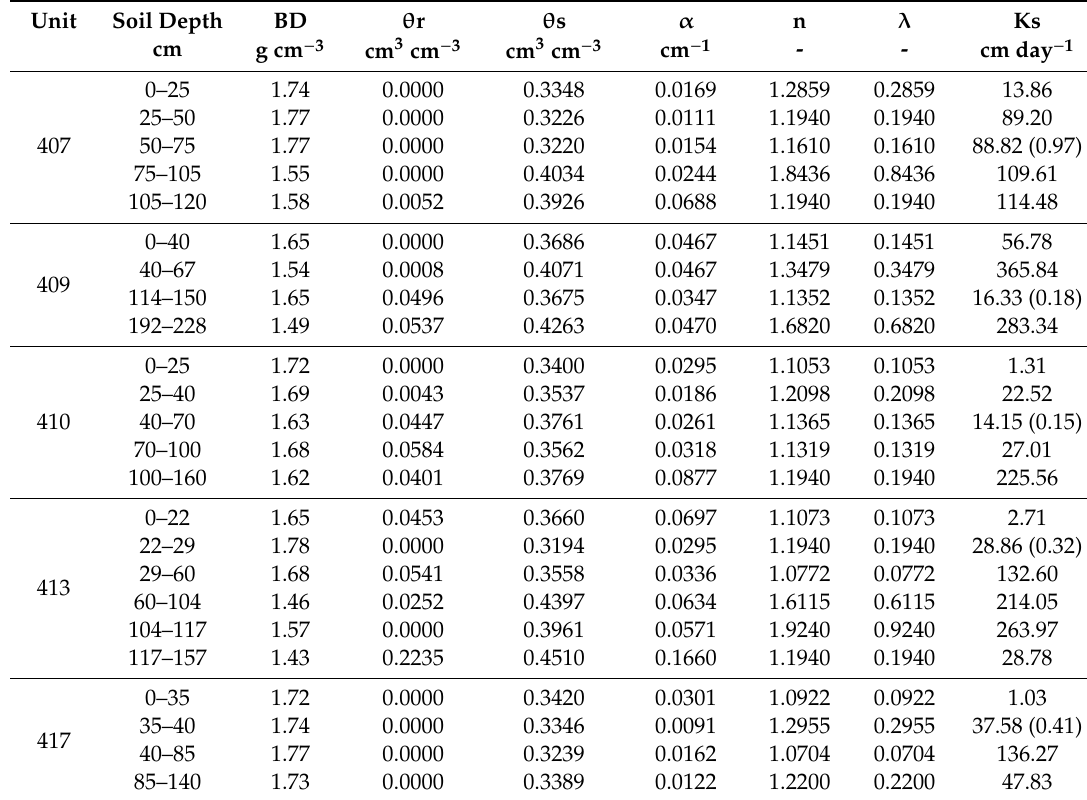
Table 2. Parameters of the Van Genuchten ( θ r, θ s: residual and saturated water contents; α : air-entry pressure; n: pore-size distribution) and the Mualem-VG ( λ : empirical pore-connectivity parameter; Ks: saturated hydraulic conductivity) curves [20], for each soil unit and horizon reported in Table